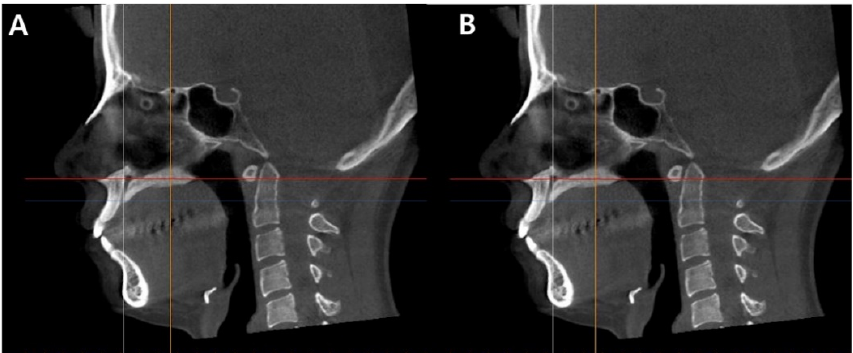
Figure 2. Sagittal view for bone density measurements: ( A ) Cone-beam computed tomography (CBCT) image was oriented so that the white vertical line was placed along the posterior border of the incisive foramen at an exit of the inferior canal. ( B ) The white vertical orientation line was then moved posteriorly by 1.56 mm to create the anterior limit for data collection.